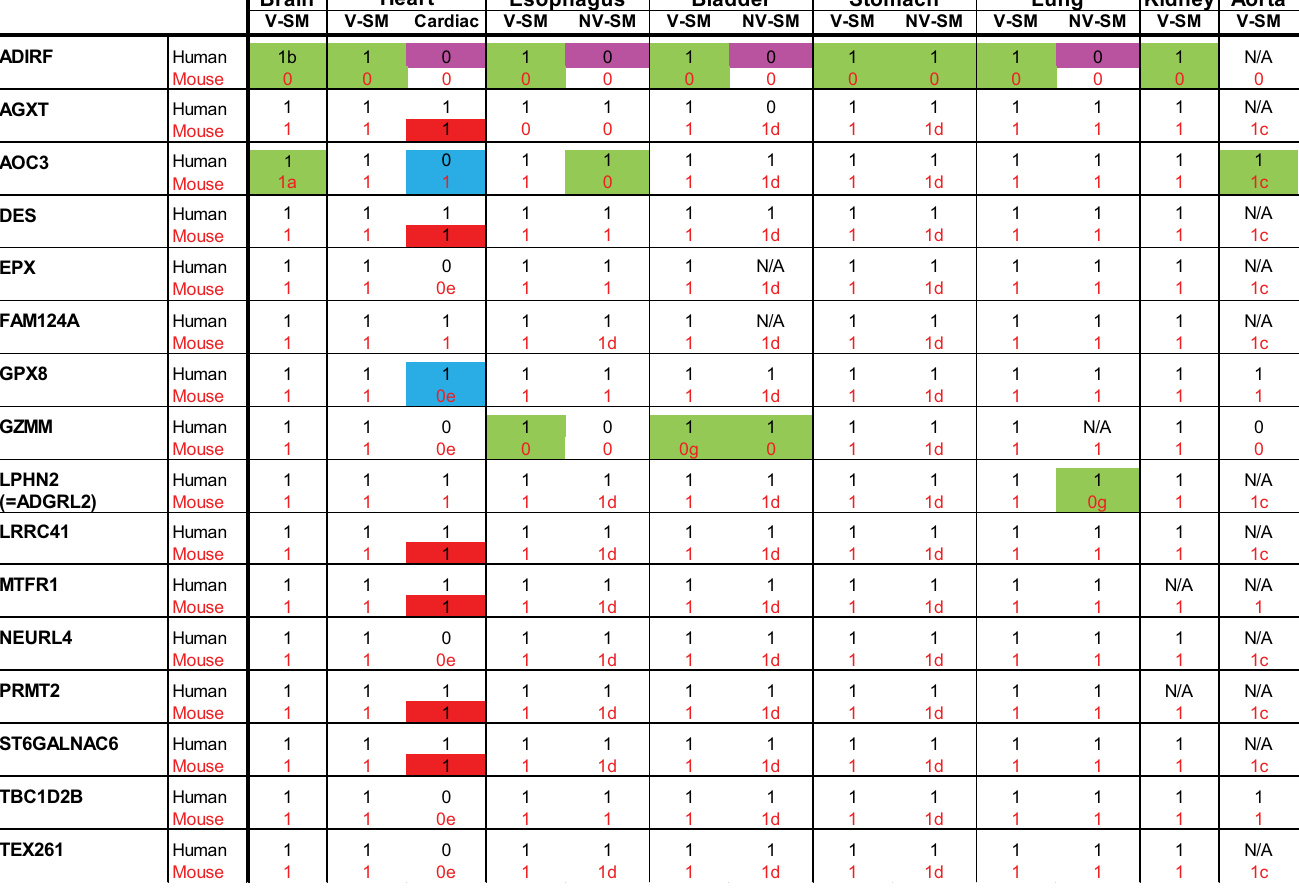
Fig 3. Summary of IHC staining of human and mouse tissues. We scored for the presence of significant and consistent staining using online data from the Human Protein Atlas for indicated human tissues. We scored mouse tissues stained for the same molecules in a blinded fashion. The presence of protein staining is indicated by 1, while the absence is indicated by 0. N/A indicates that staining was equivocal or inconsistent between samples or that the data was not available. Color codes and letters represent cases of non-conservation between cell types or species that are as follows: purple highlights show proteins expressed in VSMC but not in non-vascular SMC of the same organ in humans only; green highlights show proteins with clearcut differences in cellular staining between human and mouse tissues; blue highlights show proteins that exhibit differences in cardiomyoctes between human and mouse tissues; and red highlights show proteins that exhibited heterogeneity in cardiomyocytes. a: decreased in brain (vs. peripheral) VSMC, b: increased in brain (vs. peripheral) VSMC, c: heterogeneous in VSMC, d: heterogeneous in non-vascular SMC, e: weak, equivocal. V-SM indicates VSMC; NV-SM indicates non-vascular SMC.